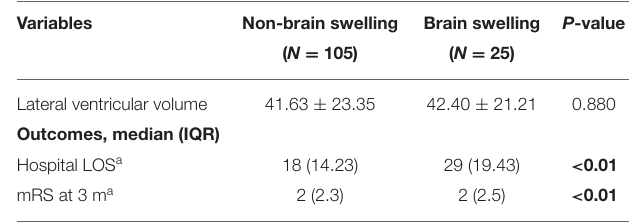
TABLE 2 | Univariate analysis of characteristics of SAH